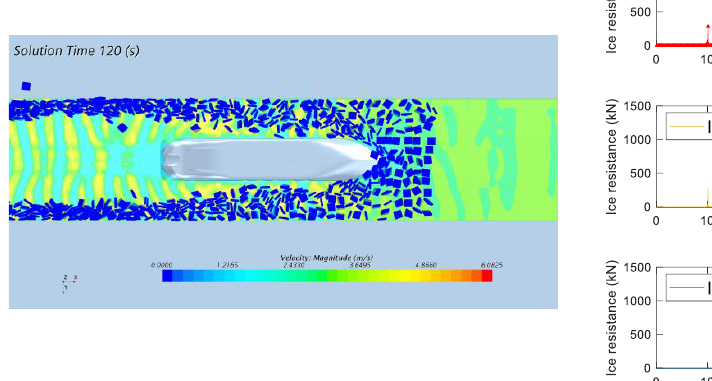
Figure 13. simulation and ice resistance of Case A: the side-nozzle ventilation rate is 1 m/s; the bow- nozzles are turned off.